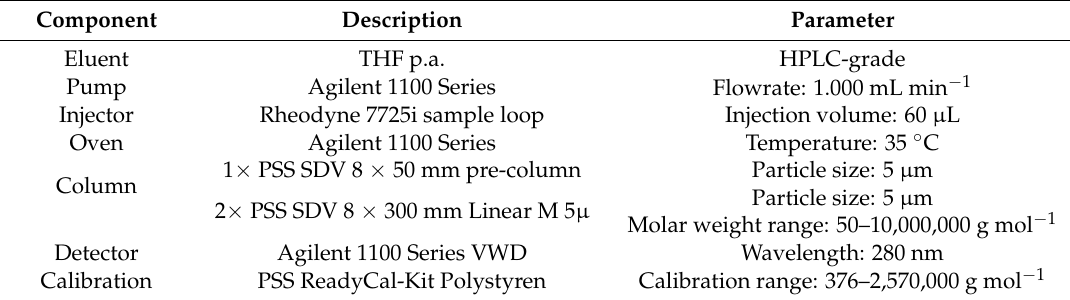
Table 11. SEC set up and